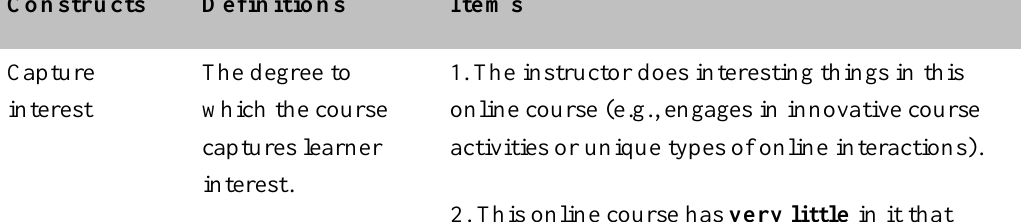
Examples of Constructs and Items used to Assess Learners’ Attention